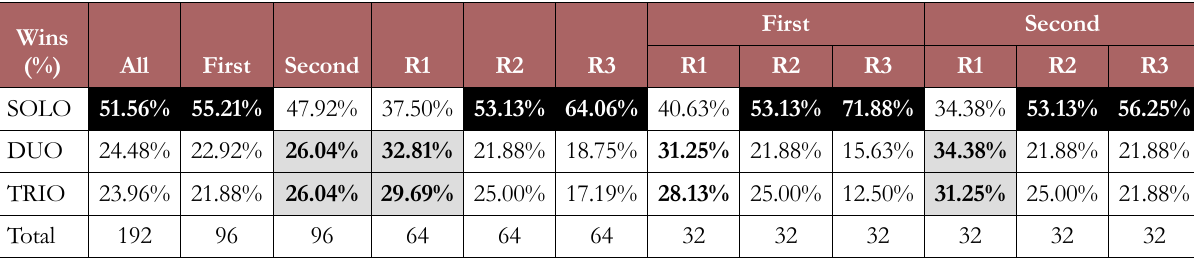
Table 6. Wins (%): pairwise differences in terms of size by right and mechanism